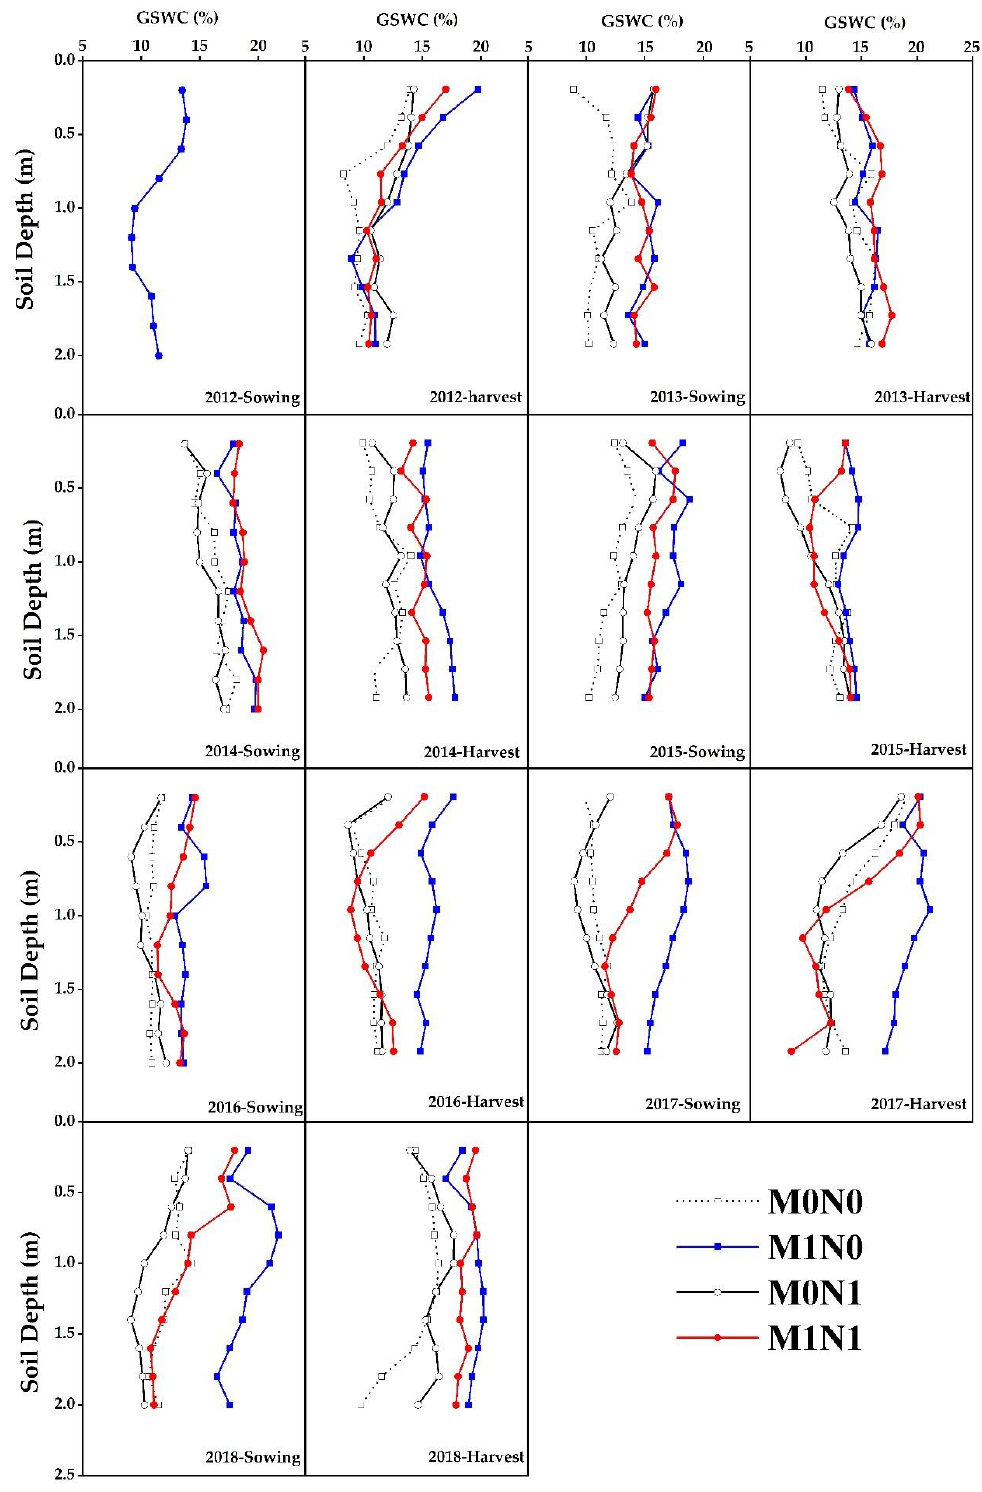
Figure 3. Soil profile water content at a depth of 0–200 cm during the experimental period. M0N0—cultivation without film mulching and N application; M1N0—cultivation with film mulching but without N application; M0N1—cultivation without film mulching but with N application; M1N1—cultivation with film mulching and N application; GSWC—gravimetric soil water content.